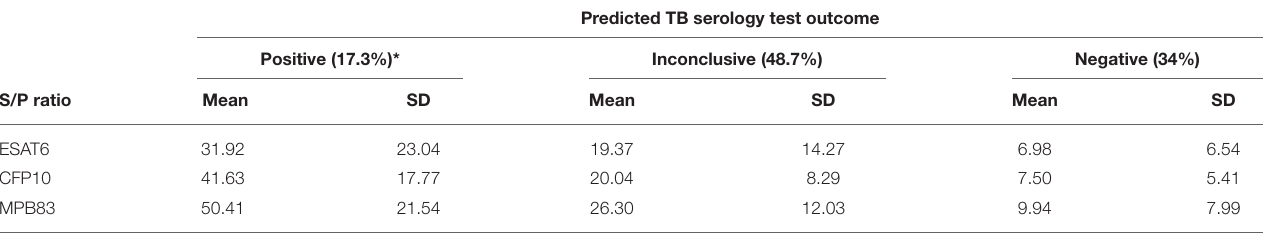
TABLE 2 | Percentages of elephants ( n = 708) per LCA predicted TB serology test outcome and concordance with the S/P ratios (mean and standard deviation) resulting from the three ELISAs for each of the TB statuses.